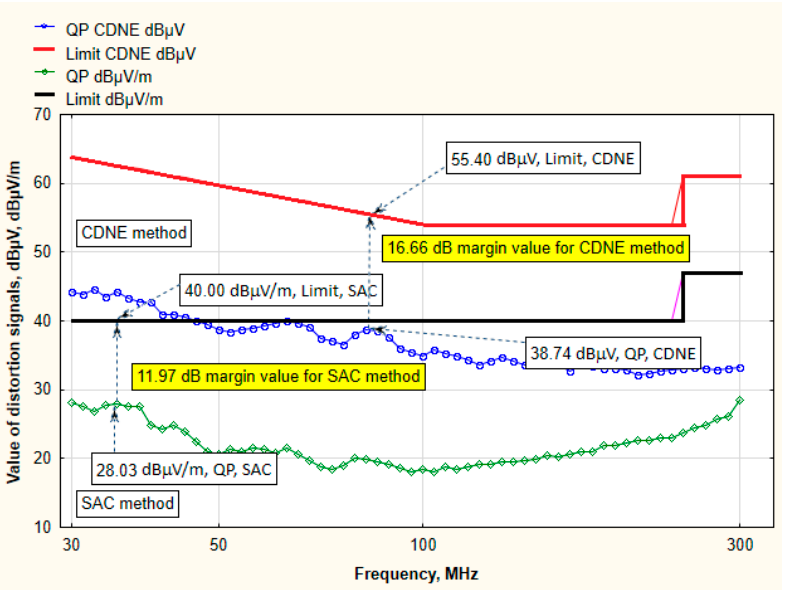
Figure 11. Recorded QP values using the new and traditional method against the allowable limits for the tested LED lamp